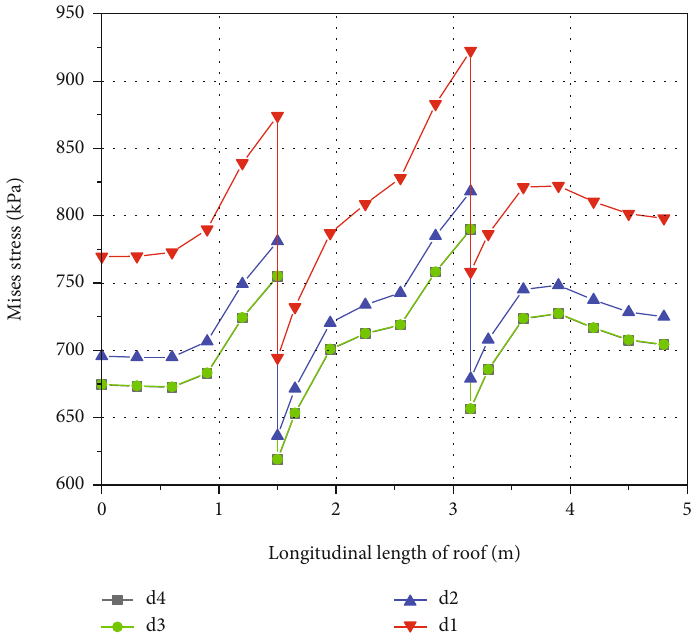
Figure 14: Longitudinal distribution curve of Mises stress on roof of integrated pipe gallery.